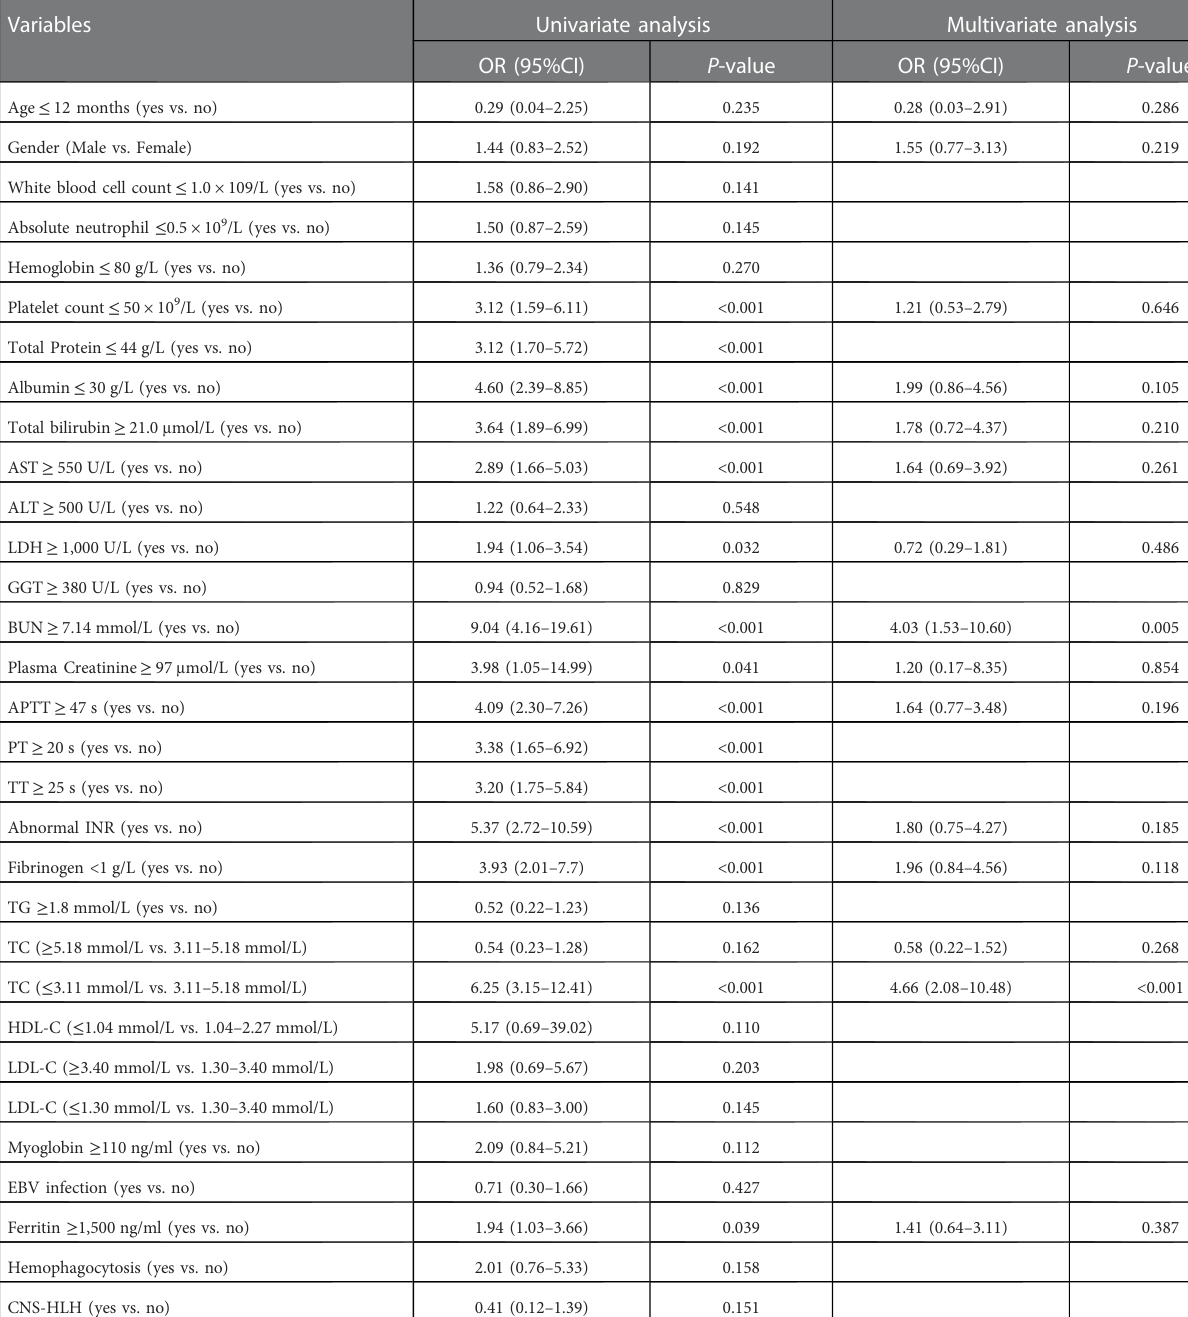
TABLE 4 Risk factors for 30-day survival by univariate and multivariate logistic regression analysis in 336 HLH patients. Variables Univariate analysis Multivariate